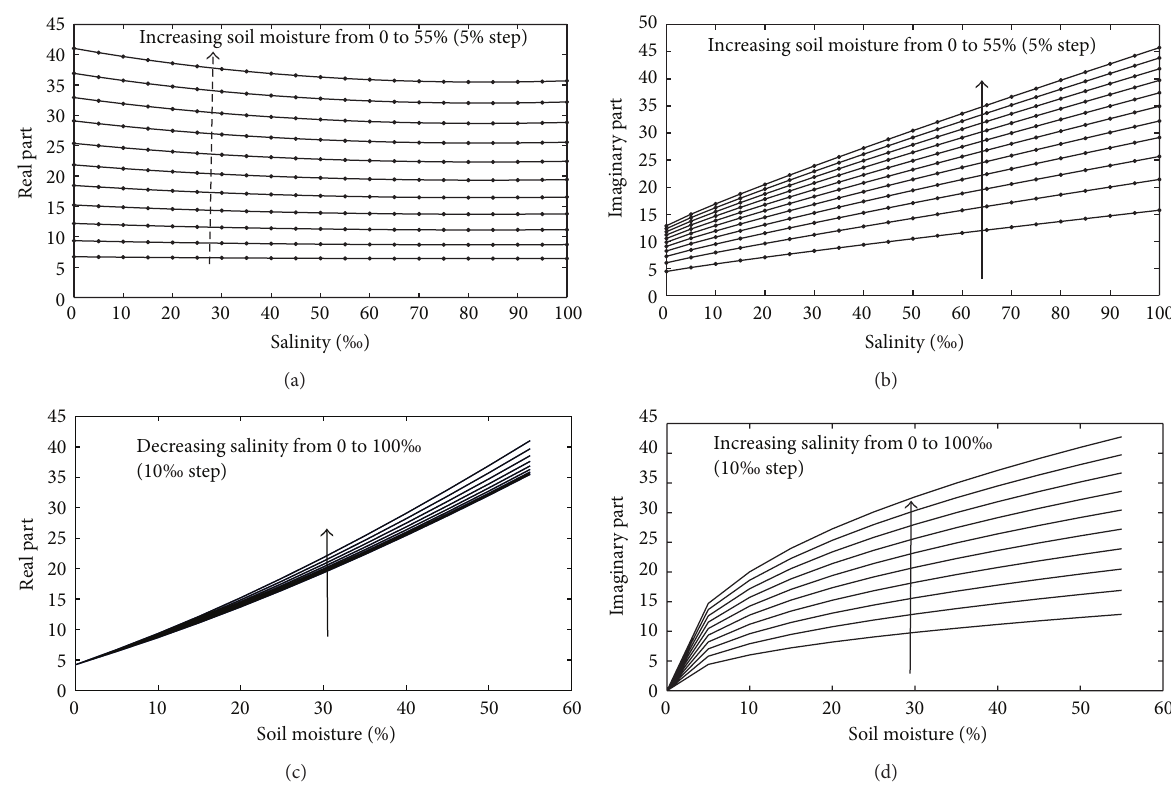
Figure 3: Effect of salinity and moisture on the sandy loam soil dielectric constant derived from the Dobson model combined with the saltwater model at 5.4 GHz. (a) Salinity effect on the real part, (b) salinity effect on the imaginary part, (c) soil moisture effect on the real part, and (d) soil moisture effect on the imaginary